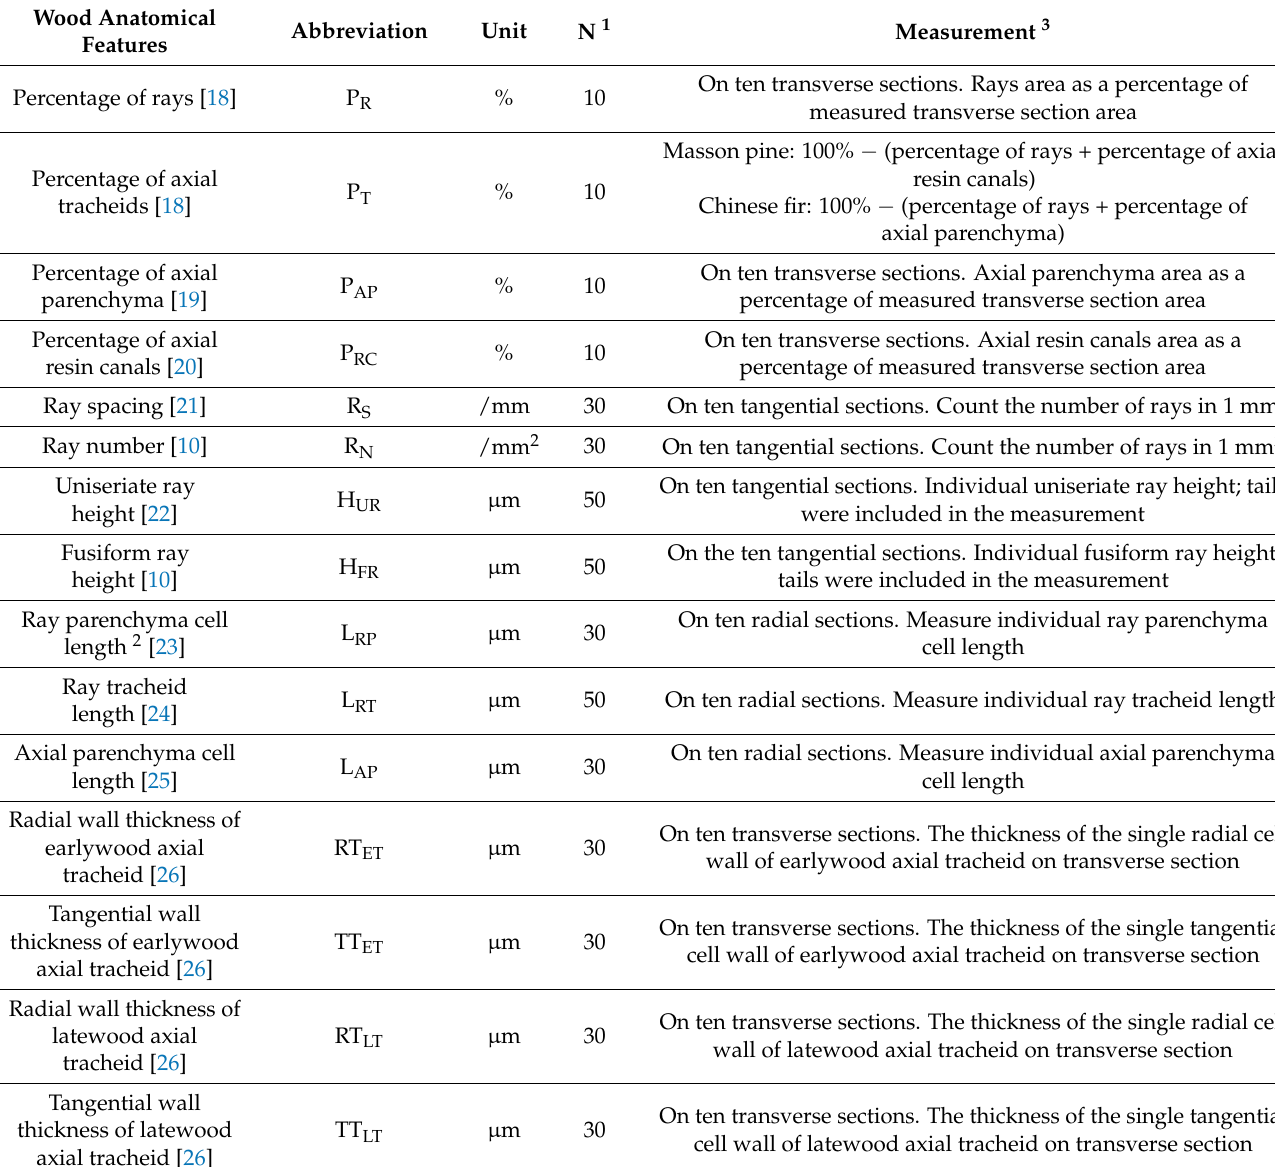
Table 1 presents the feature abbreviations and their statistical analysis methods. Table 1. Measured wood anatomical features of Masson pine and Chinese